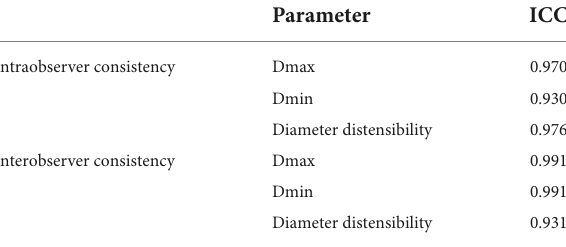
was employed to assess the consistency between observers.